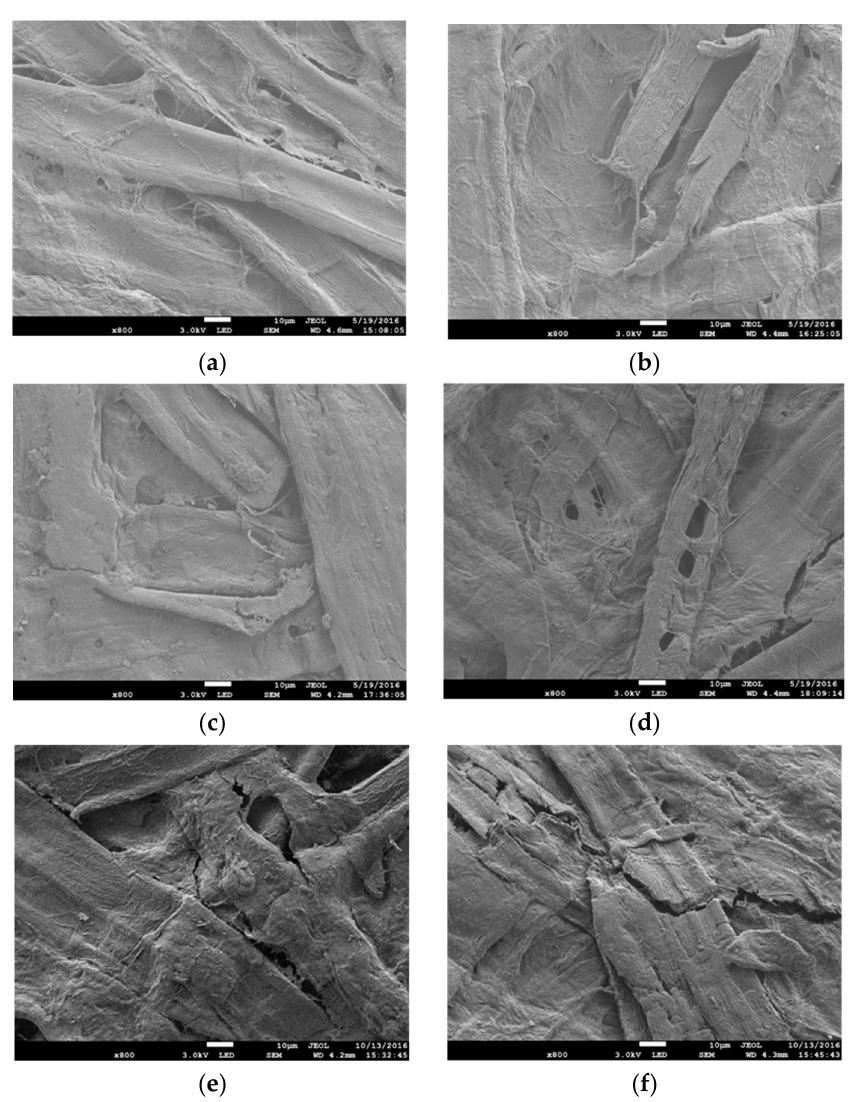
Figure 14. Scanning electron microscopy (SEM) images of paper thermally aged for various durations at 130 °C. ( a ) 0 day; ( b ) 10 days; ( c ) 22 days; ( d ) 35 days; ( e ) 60 days; ( f ) 90 days.